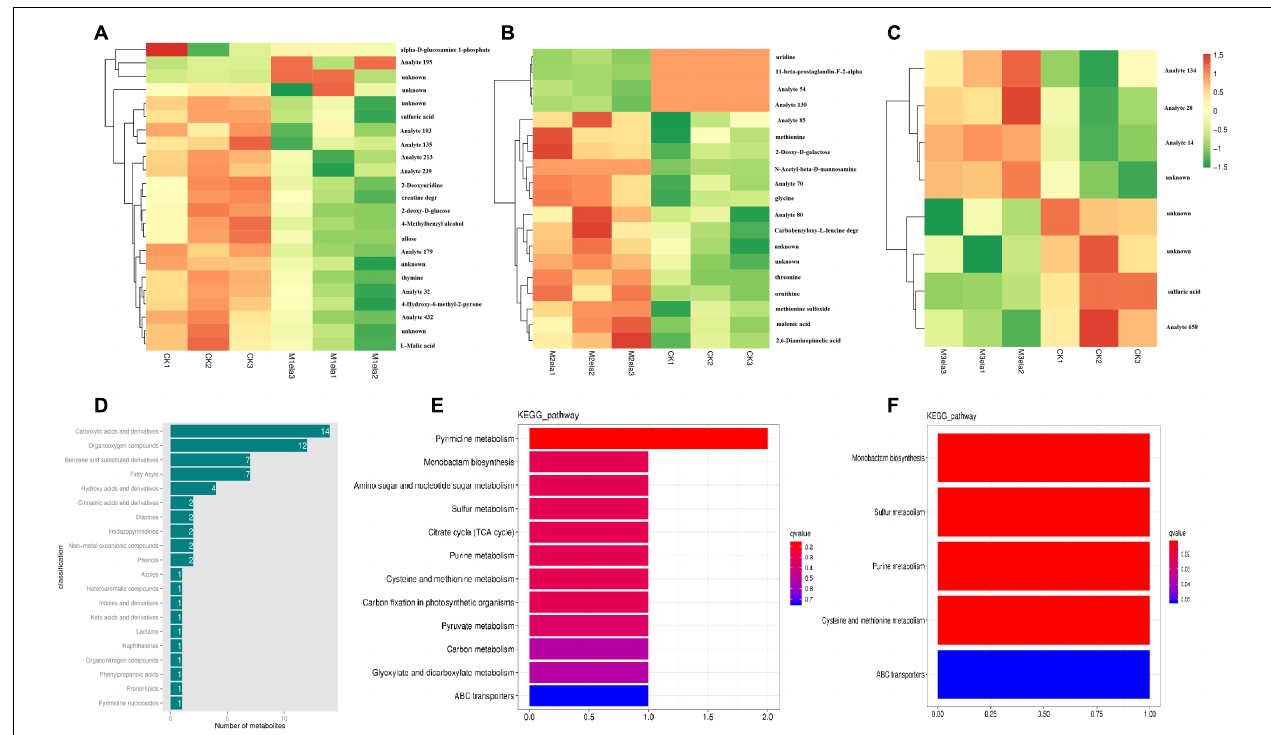
FIGURE 6 | Melatonin affects the metabolism of stylo silage supplemented with melatonin ( n = 3).Heatmap analysis of different metabolites identified from GC-MS analysis in stylo silage after melatonin addition ( A , CK vs. Mela1; B , CK vs. Mela2; C , CK vs. Mela3) ( n = 3). (D) The top 20 metabolites were classified. KEGG analysis of different metabolites identified from GC-MS analysis in the silage after melatonin addition ( E , CK vs. Mela1; F , CK vs. Mela3) ( n =